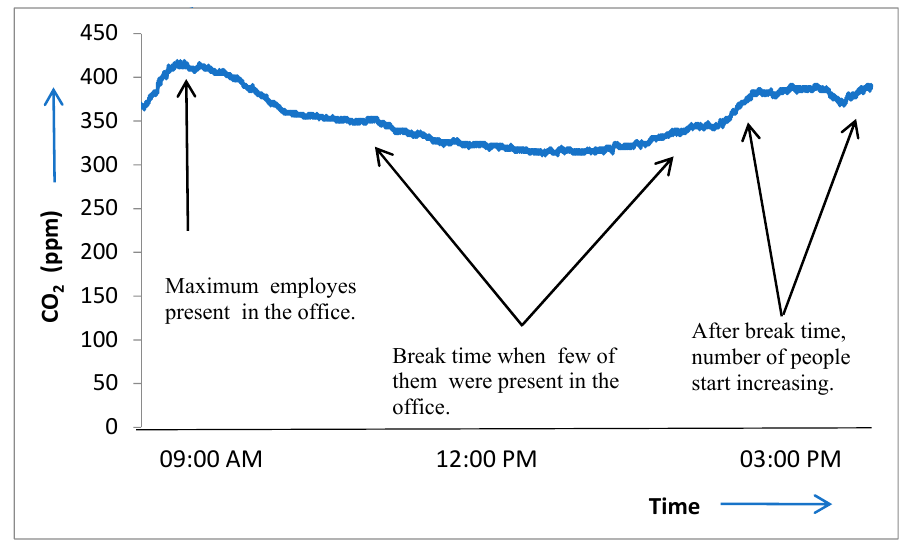
Figure 10. CO 2 measurements over six hours in the office setting. Figure 11. CO Figure 11. CO 2 measurements over six hours in the office setting. 2 measurements over six hours in the office setting.